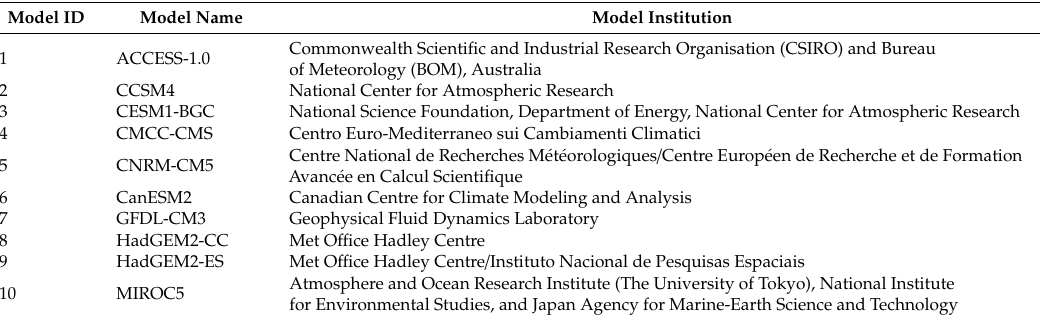
Table A1. GCMs selected for California water resources planning 1